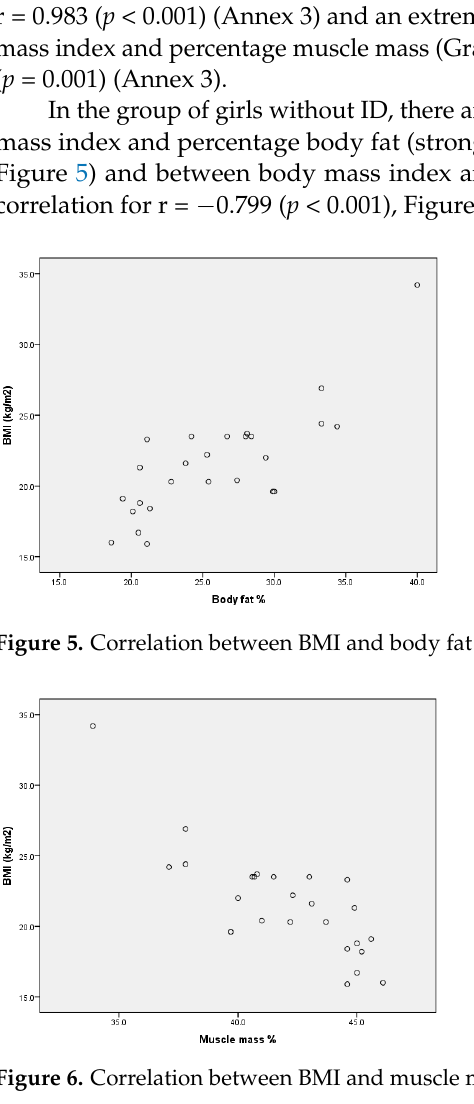
Figure 6. Correlation between BMI and muscle mass % for the group of girls without ID.